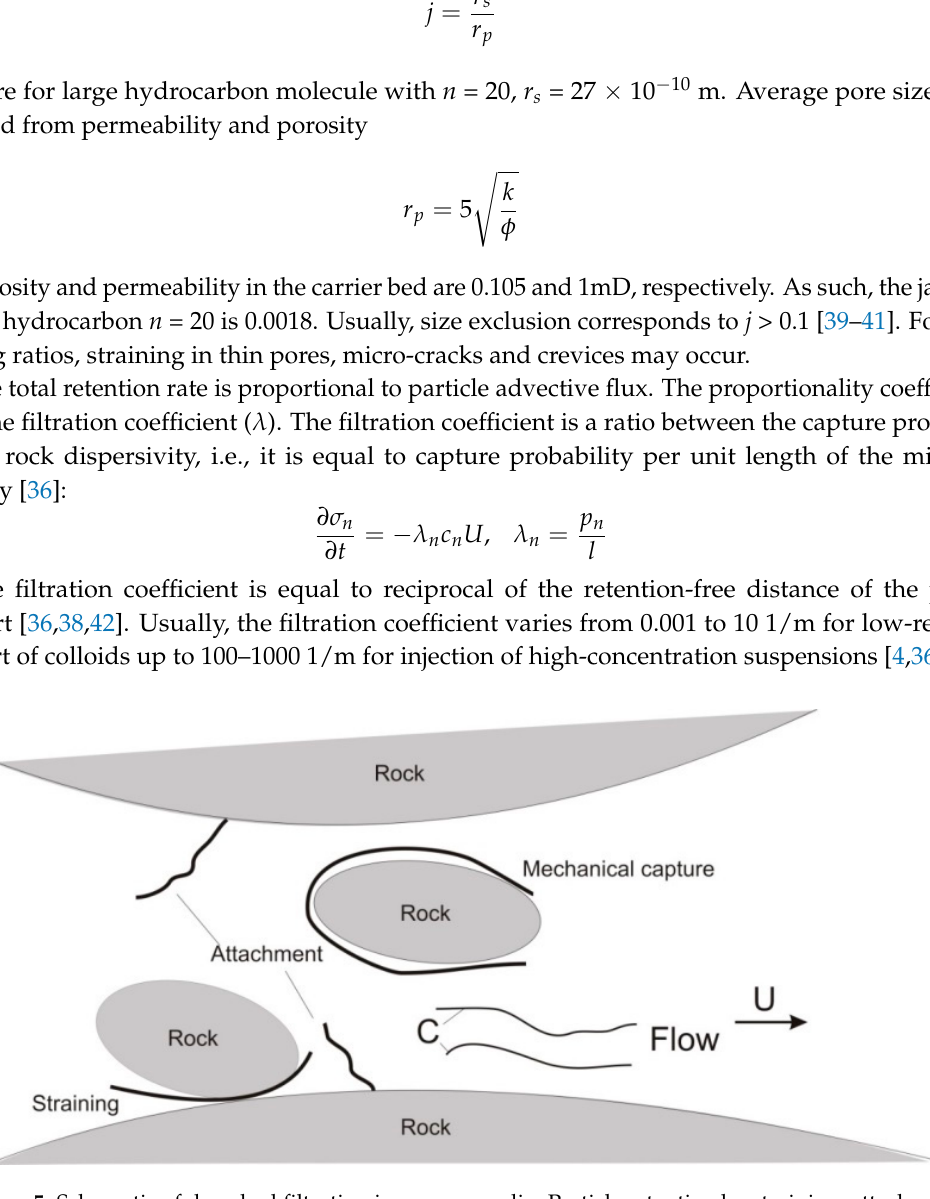
Figure 5. Schematic of deep bed filtration in porous media. Particle retention by straining, attachment and mechanical entrapment. C presents the hydrocarbon component and U is the flow velocity.